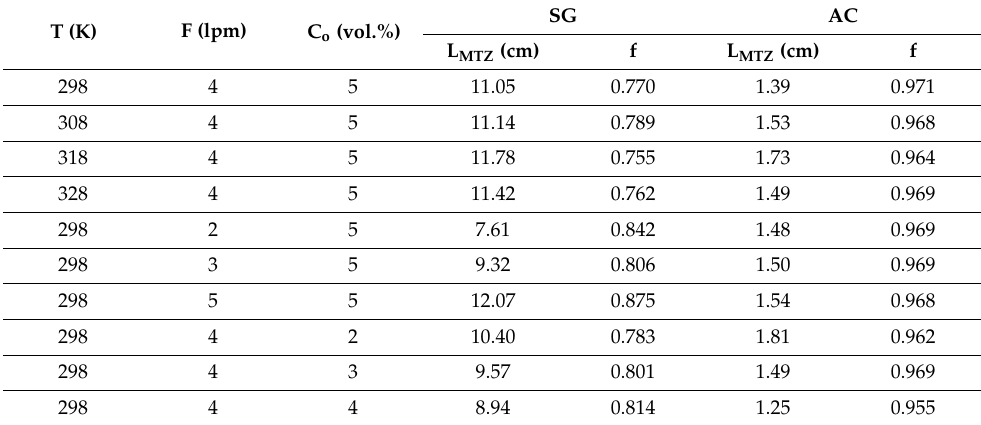
Table 4. Characteristic parameters of CO 2 adsorption for both adsorbents.